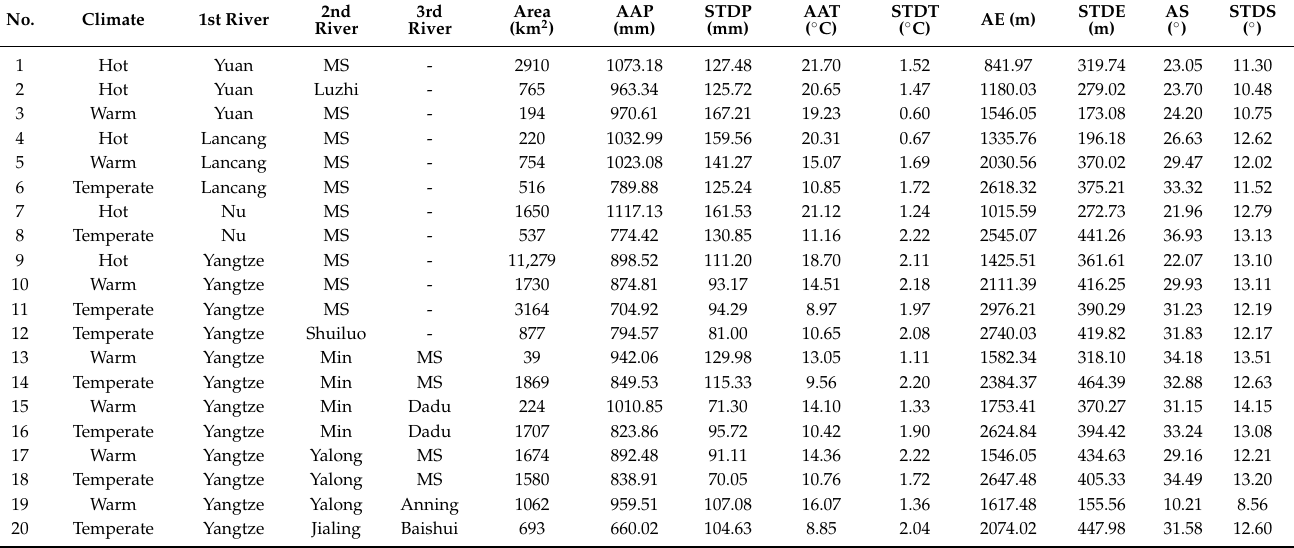
Table 2. Basic information of 20 main dry valleys in Southwest China.